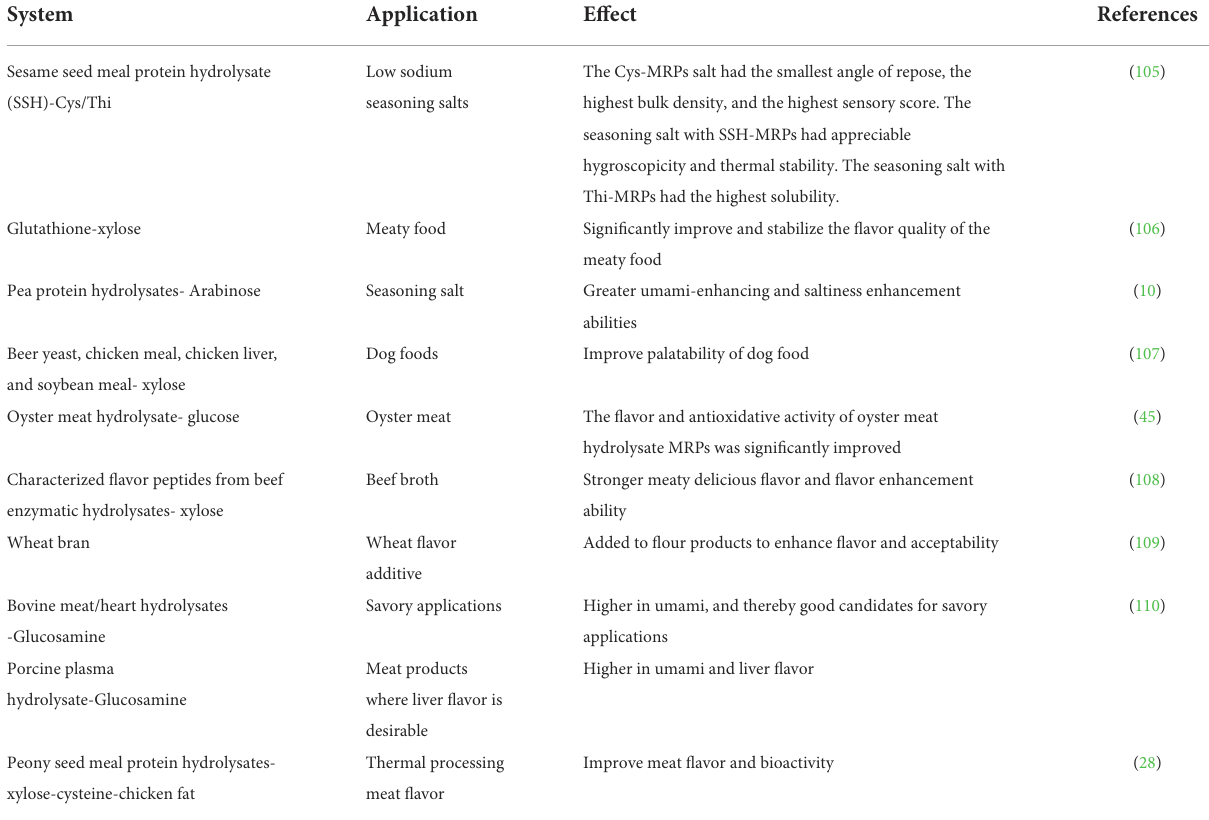
TABLE 4 The latest studies on the role of the Maillard reaction in the production of